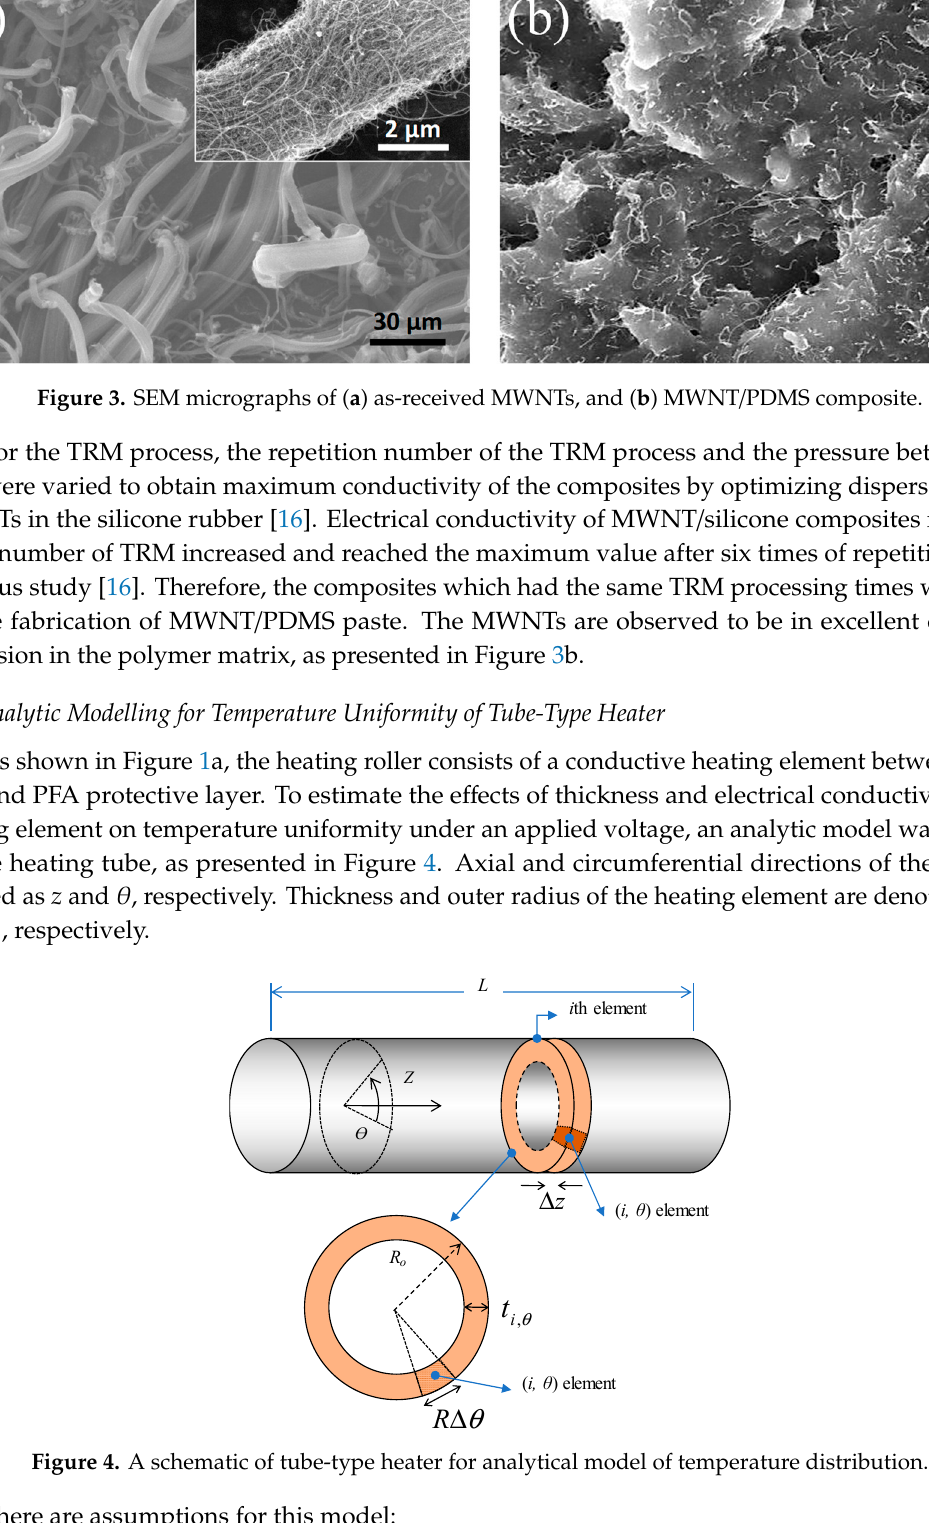
Figure 4. A schematic of tube-type heater for analytical model of temperature distribution.